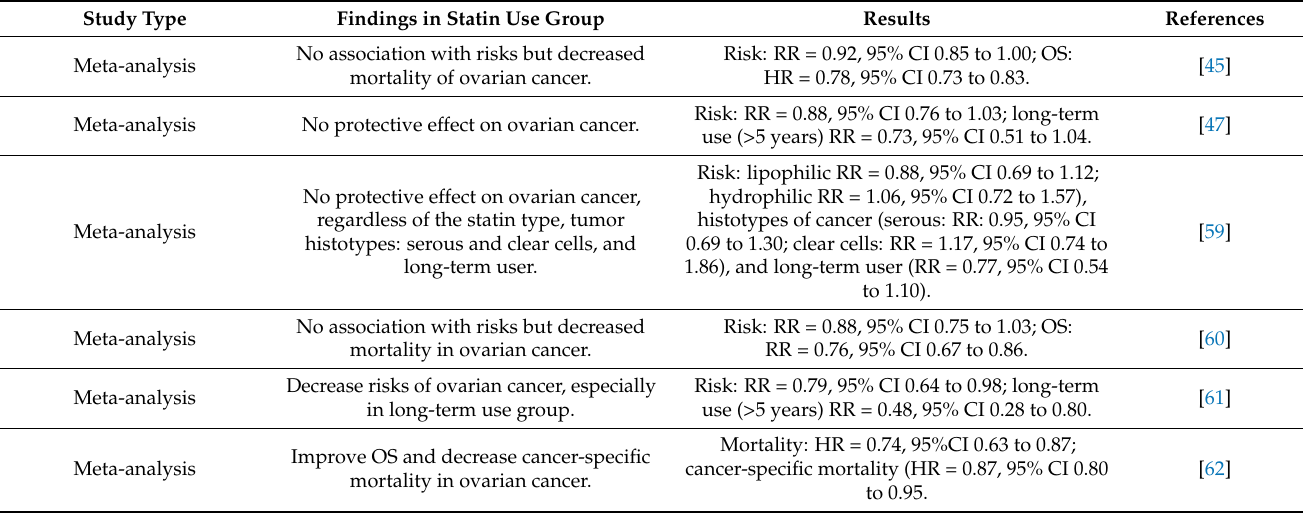
Table 3. Clinical studies of statins in ovarian